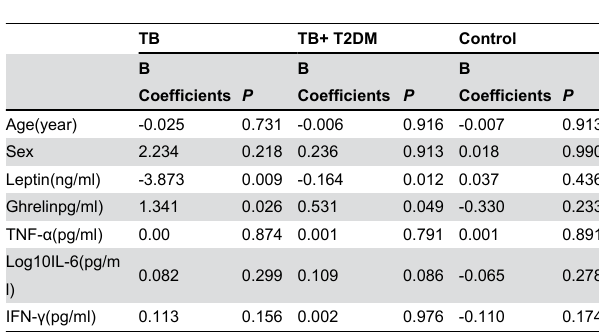
Dependent Variable: BMI. Abbreviations: IL-6, interleukin-6; TNF-α, denotes tissue necrosis factor-α; IFN-γ,interferon-γ. doi: